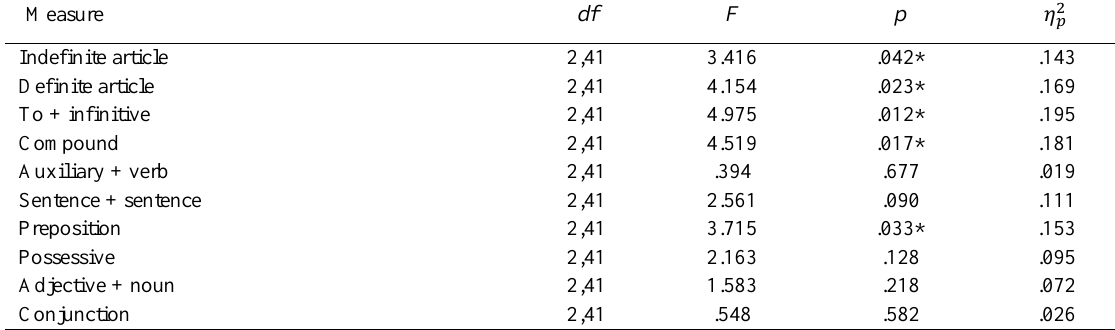
Table 6. ANOVA results for between-subject effects in mean fixation duration in Experiment 1. Measure